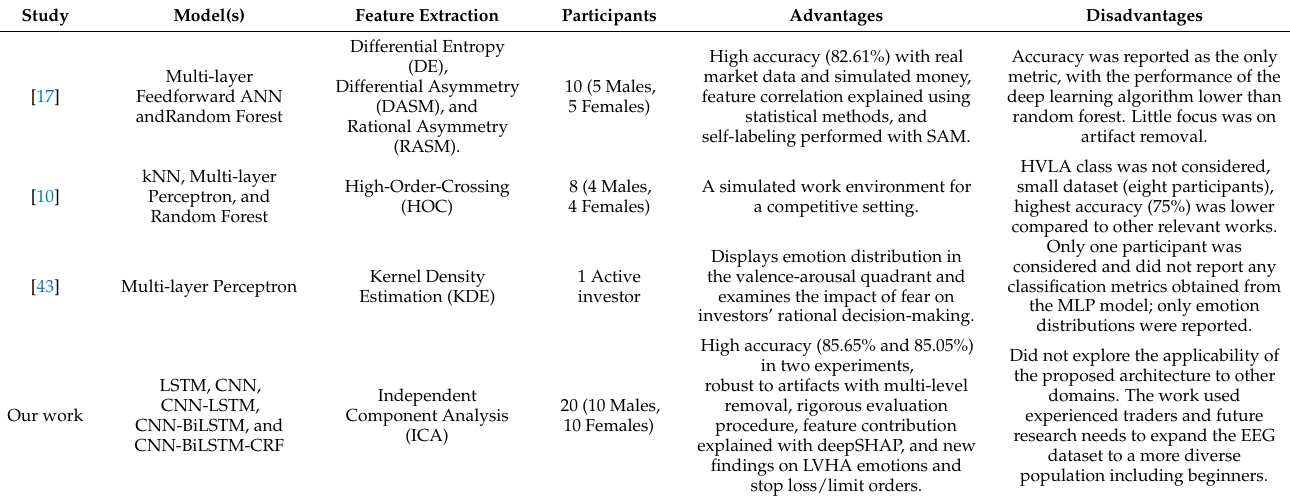
Table 8. Comparing the proposed framework with past